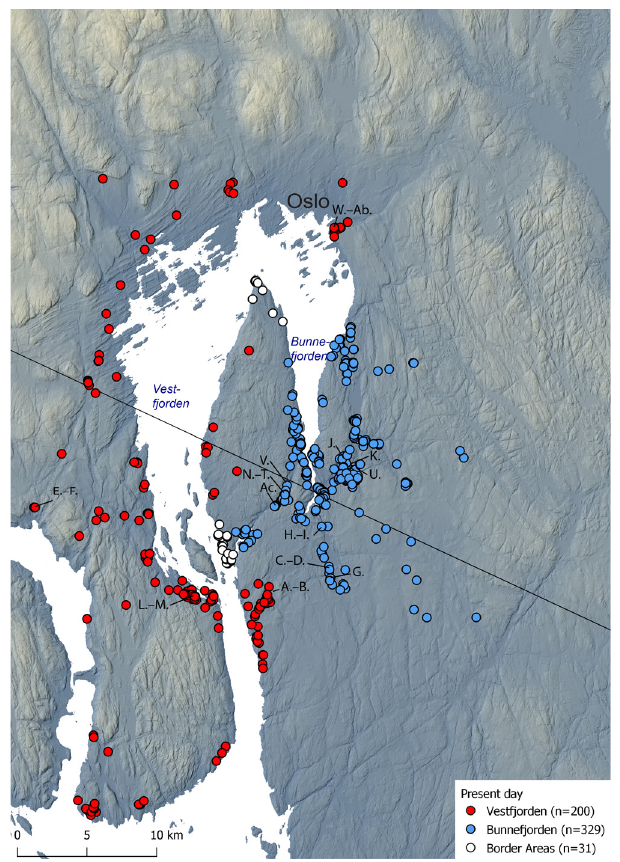
Figure 3: The present - day landscape in the Oslo Fjord area with the 329 critically selected sites located in the Bunnefjorden area and the 200 sites in the Vestfjorden area. The black line marks a base - isobar with an orientation of N30°E established by the direction of the isostatic rebound in the Oslo Fjord area. To obtain a more precise shore level date, the sites have been recalibrated in accordance with the distance to this base. Illustration: Isak Roalkvam,